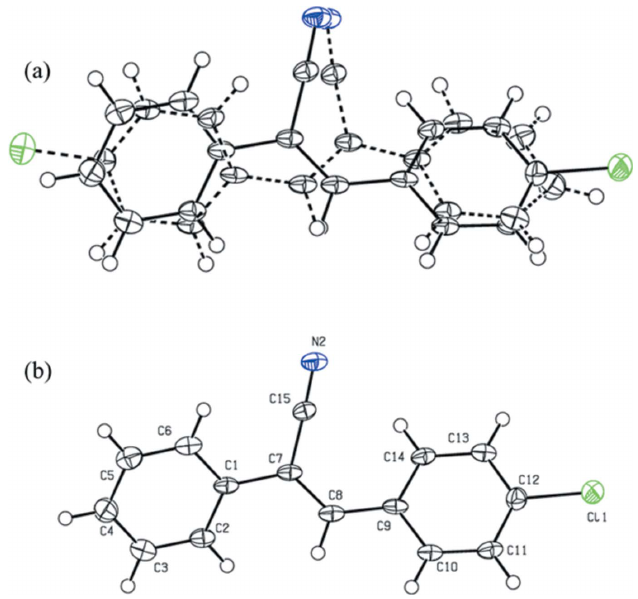
Figure 1 ( a ) The disordered components of compound I (major shown with solid lines and minor with broken lines) and ( b ) displacement ellipsoids of the major disordered component of I at the 50% pobability level, with the atom-labelling